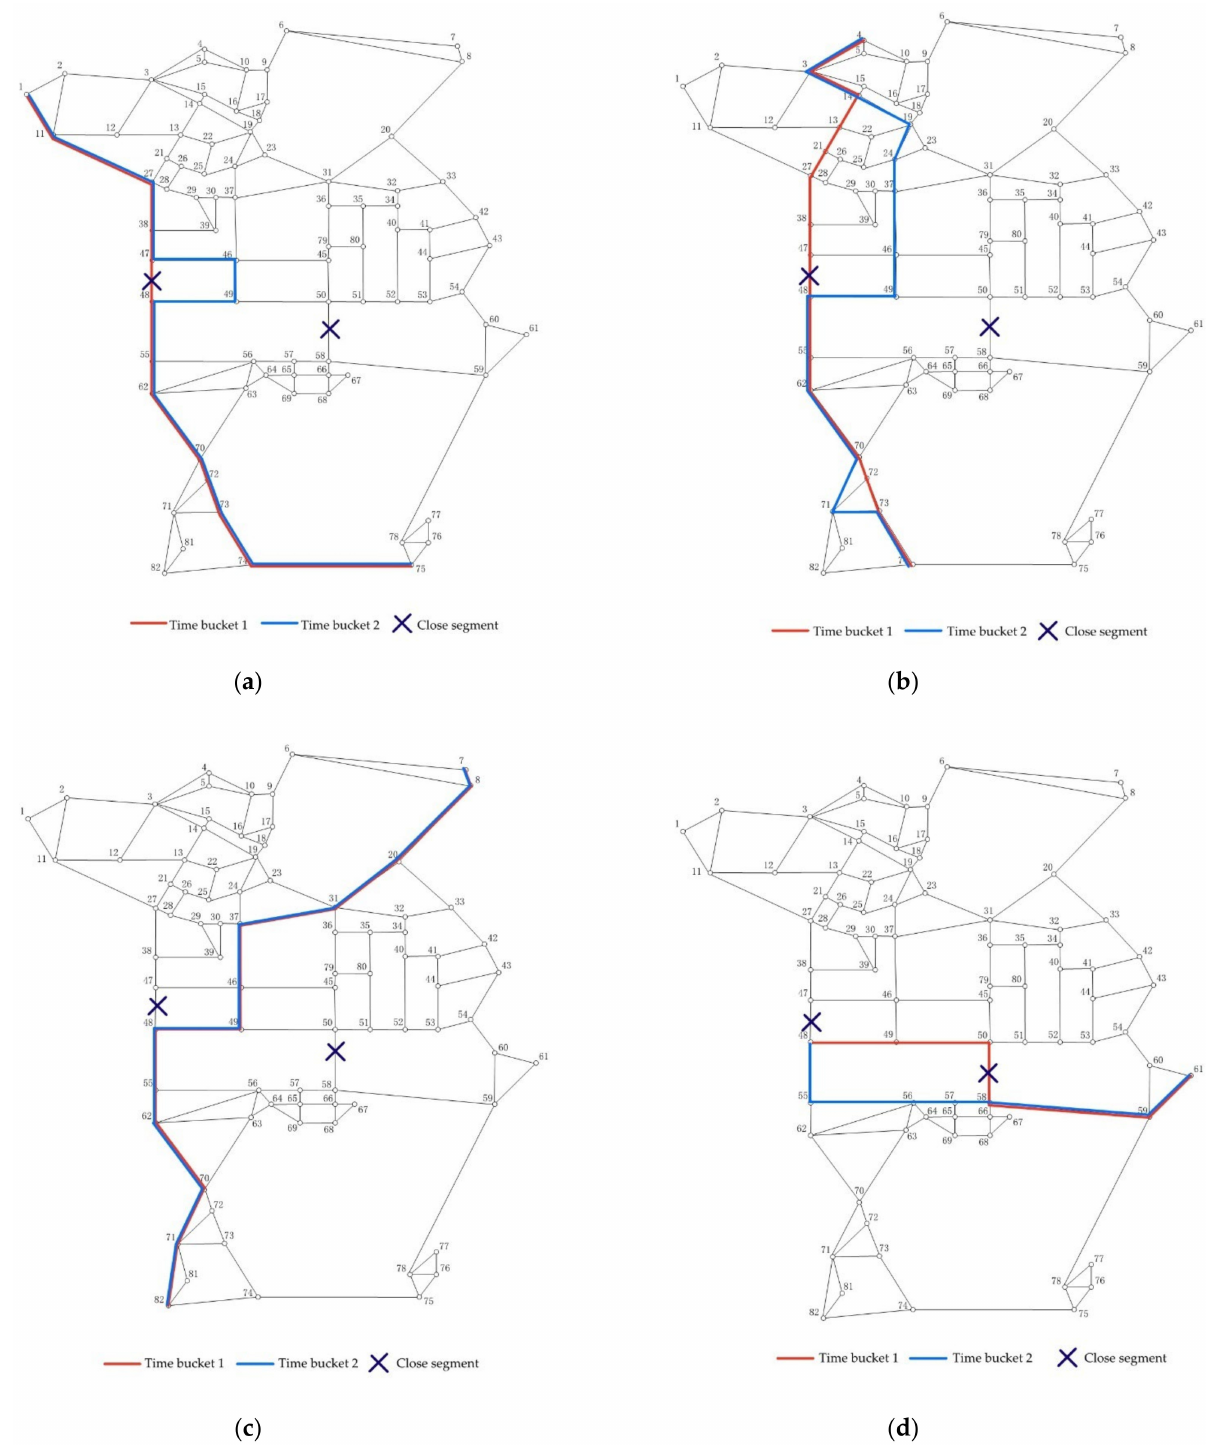
Figure A3. Given some close segments, ( a ) The route from points 1 to 75. ( b ) The route from points 4 to 74. ( c ) The route from points 7 to 82. ( d ) The route from points 48 to